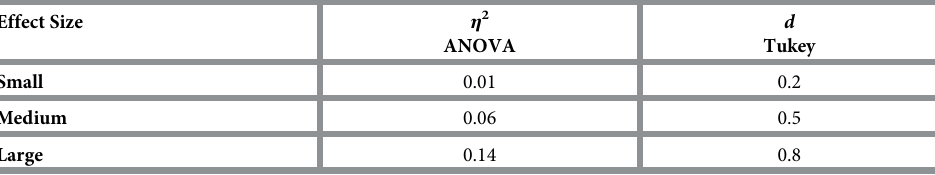
Table 2. Relative magnitudes for the effect sizes for the ANOVA ( η 2 ) and Tukey ( d ) analyses